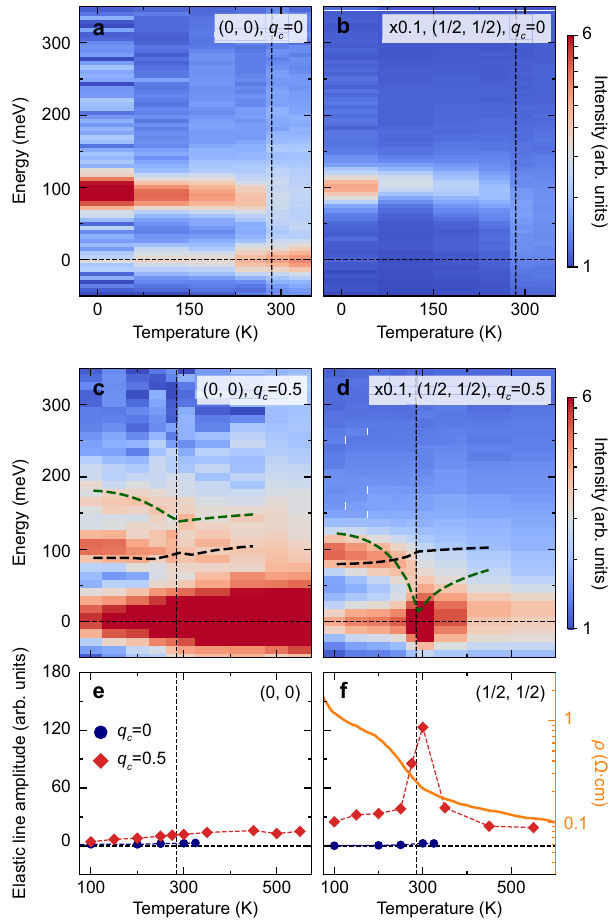
Fig. 4 Excitonic mode condensation at the Néel temperature. a – d Temperature dependence of the Sr 3 Ir 2 O 7 excitation spectrum at (0, 0) and (0.5, 0.5) for q c = 0 and 0.5 (RIXS spectra at selected temperatures are shown in Supplementary Fig. S2). The intensity at (0.5, 0.5) has been scaled for comparison reasons. The dashed lines show temperature- dependent calculations of our model (the full theoretical predictions are plotted in Supplementary Fig. S5). Based on the q c behavior of the modes, we know that panels a , b show only the transverse mode, while c , d show both the transverse and longitudinal mode. e , f Quasi-elastic intensity as function of temperature for q c = 0 and 0.5 in blue and red, respectively. The non-monotonic enhancement at q c = 0.5 in e provides additional support that the condensation of the excitonic longitudinal mode establishes the magnetic long-range order in Sr 3 Ir 2 O 7 . Panel f also shows the anomalous temperature dependence of the electric resisitivity ρ (taken from 30 ), which shows a change in gradient at T N further indicating that charge fl uctuations are involved in the